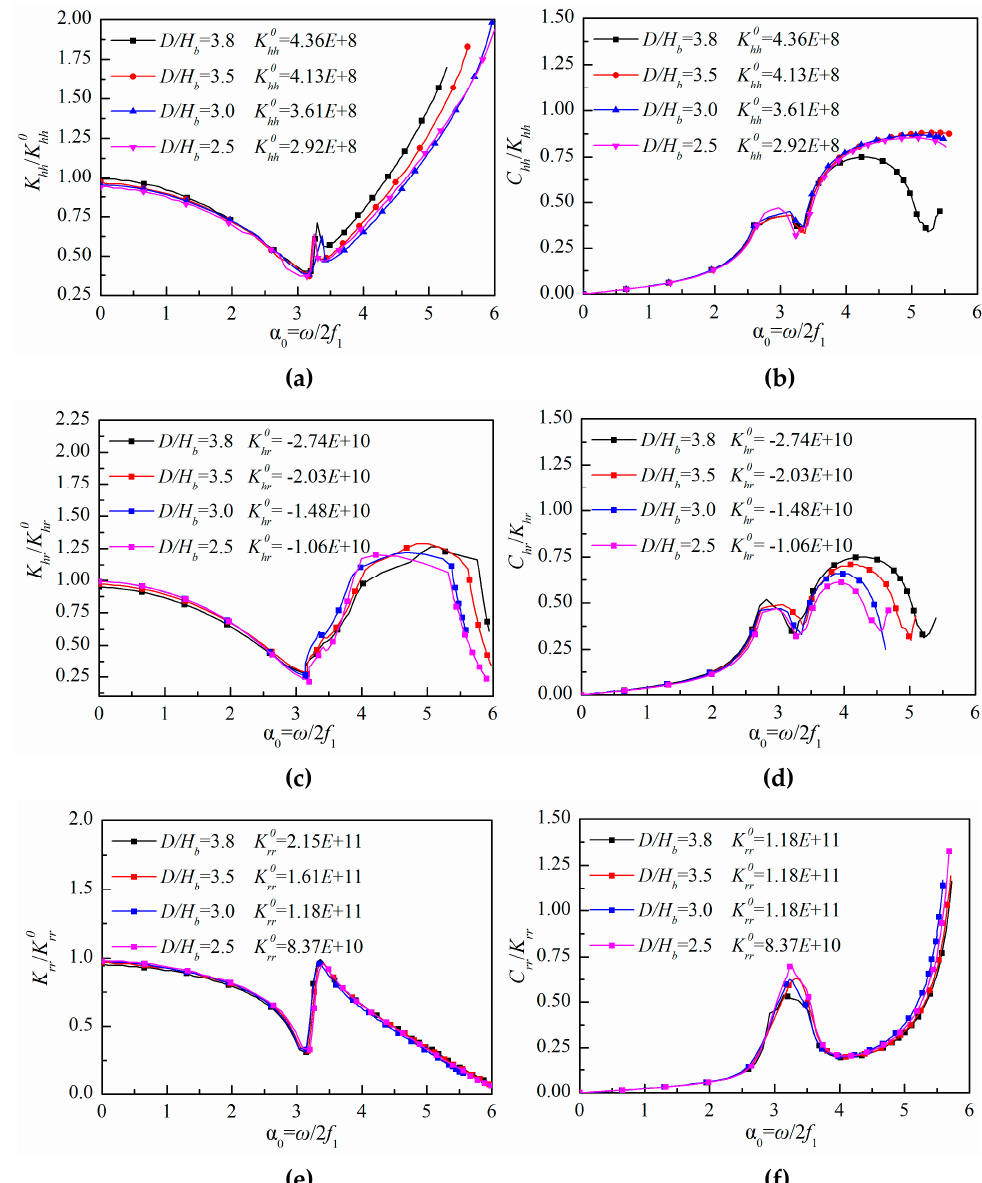
Figure 10. Variation of three dynamic impedance coefficients with respect to the dimensionless frequency under different diameter of WSBF: ( a ) Horizontal stiffness coefficient; ( b ) horizontal damping coefficient; ( c ) coupling stiffness coefficient; ( d ) coupling damping coefficient; ( e ) rocking stiffness coefficient; ( f ) rocking damping coefficient.